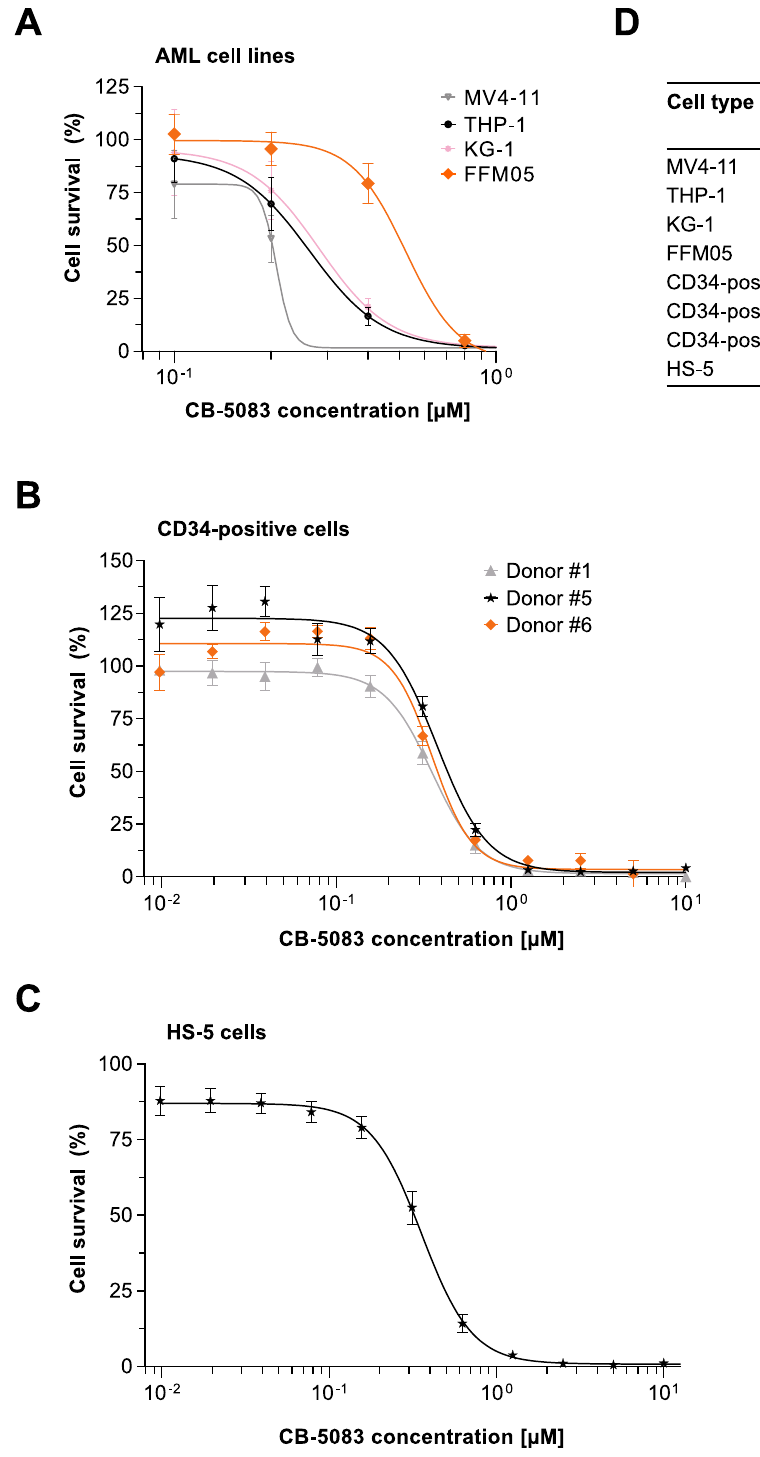
Fig 4. VCP inhibition reduces AML cell growth and survival. (A) AML cell lines THP-1, MV4-11, and KG-1 as well as the primary AML long term culture FFM05 were treated with different concentrations of CB-5083 and NMS-873. Cell count was measured after 72 hours and IC 50 values for all cell lines were estimated. Additionally, IC 50 values for CB-5083 were determined for CD34-positive cells from donors (B) and for the human bone marrow stromal cell line HS-5 (C). (D) Summary of all determined IC 50 values.